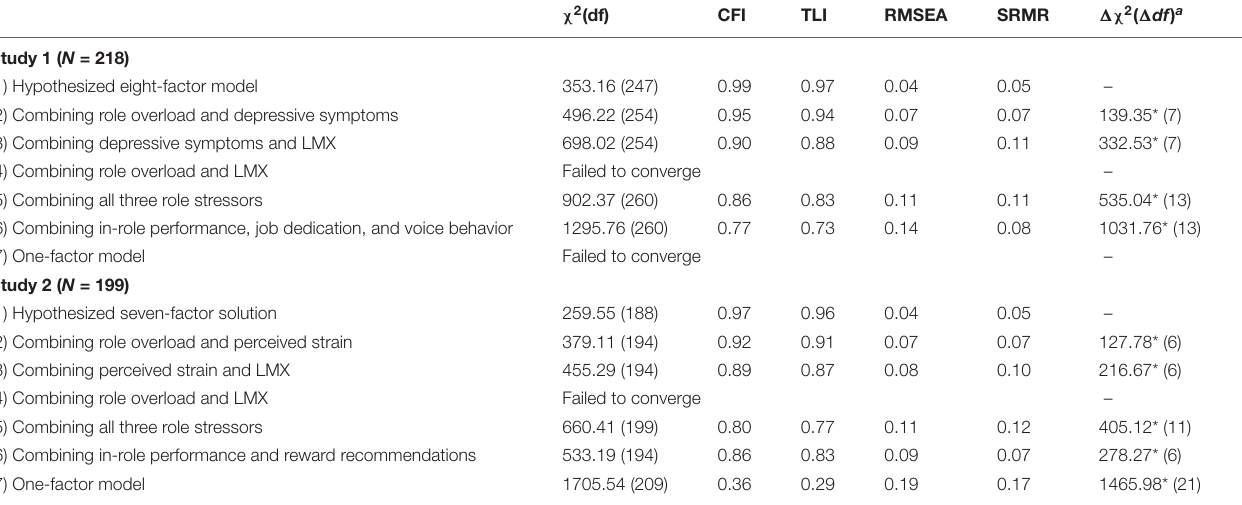
TABLE 1 | Study 1 and Study 2 Confirmatory Factor Analysis Results: Fit Indices.